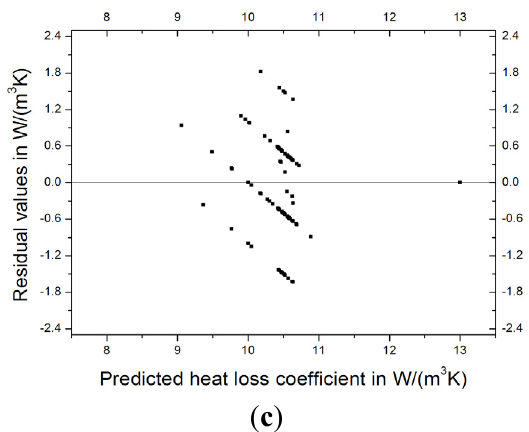
Figure 9. Testing results of 137 samples using the GRNN for the prediction of heat loss coefficient. ( a ) Predicted values versus actual values; ( b ) Residual values versus actual values; ( c ) Residual values versus predicted values.